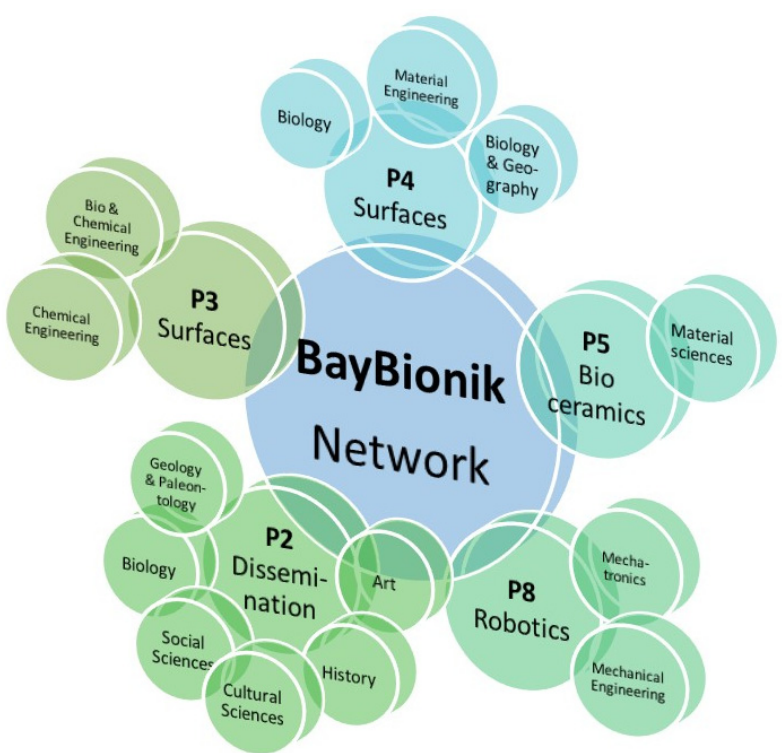
Figure 2. Scientific disciplines of the team members involved in the projects. Project leaders added their expertise. P6 and P7 did not offer detailed information. P2 was added, as it showcases the variety of disciplines that can contribute to biomimetic projects.